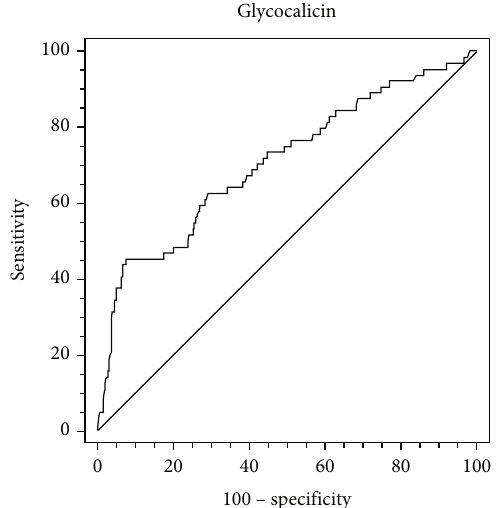
Figure 1: Optimal cut-o ff value was determined for glycocalicin using standard receiver-operating characteristic curve